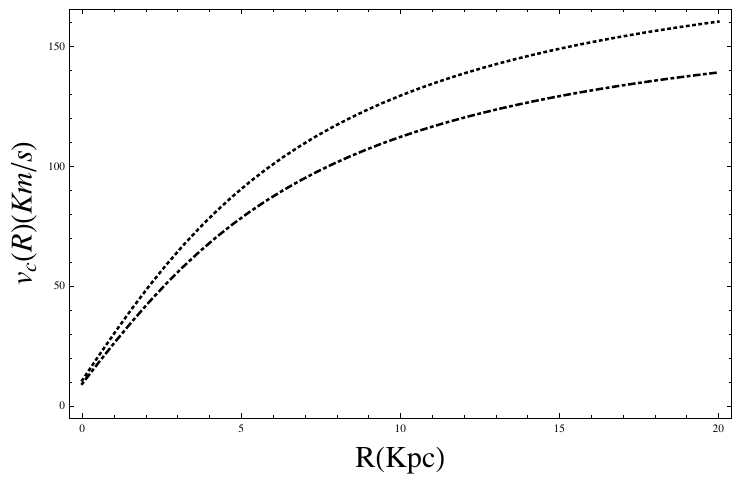
Figure 4. The rotation curve induced by DM component (third line of Equation (88)): GR + DM (dashed and dotted line) and FOG + DM (dotted